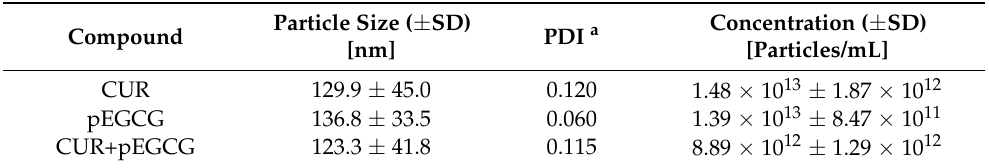
Table 1. The size of the liposomes and their concentration as prepared immediately before the biological activity study.